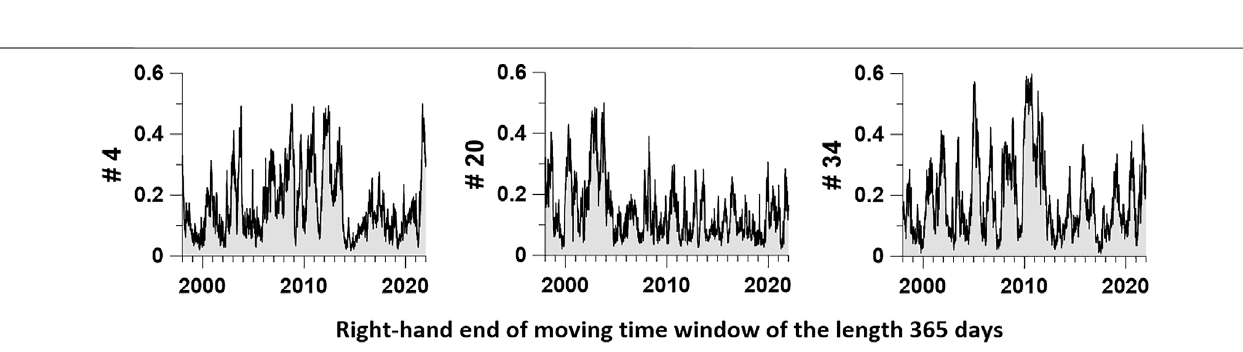
FIGURE7| PlotsofmaximumvaluesofquadraticcoherencesbetweendaylengthLODandthe fi rstprincipalcomponentof3seismicnoiseproperties γ , Δα and En at 3 reference points numbered 4, 20 and 34 when estimating in a sliding time window of 365 days with a 3 day offset.